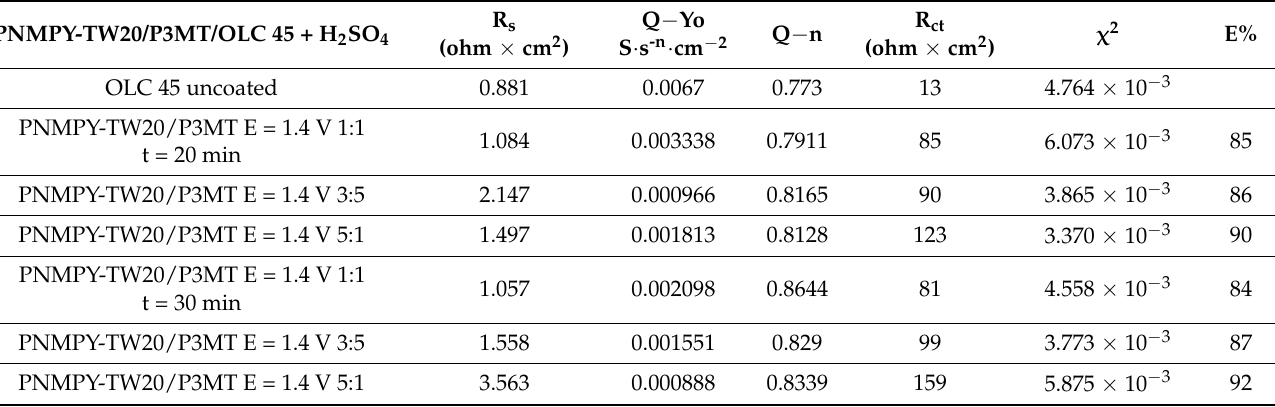
Table 9. EIS parameters of uncoated and coated by PNMPY-TW20/P3MTof OLC 45 sample in 0.5 M H 2 SO 4 medium at 25 ◦